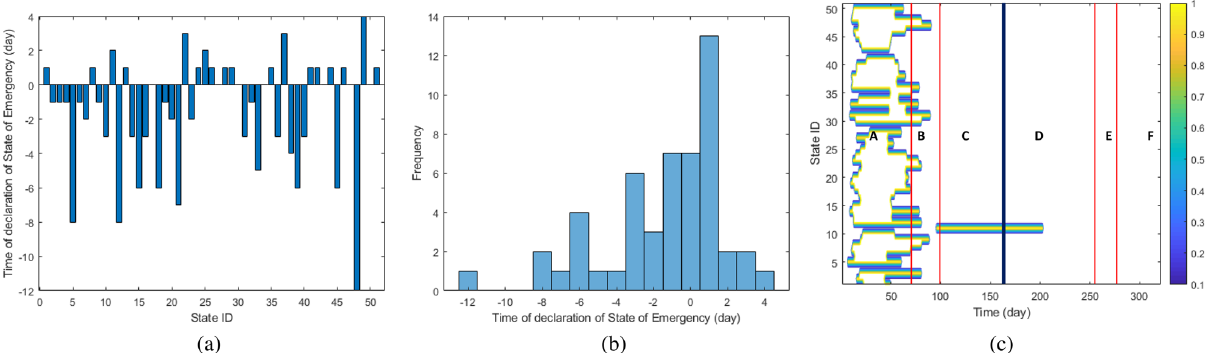
Figure 7. ( a ) The timing of announcement of SOM by each State. The IDs associated with each US State is presented in Table 1. ( b ) The histogram of the timing of announcement of SOM by each State. The histogram almost follows a bell-shape trend, suggesting a normal distribution of SOM announcement timing in the US. ( c ) The timing of announcement of “shelter at place” by each State.The IDs associated with each US State is presented in Table